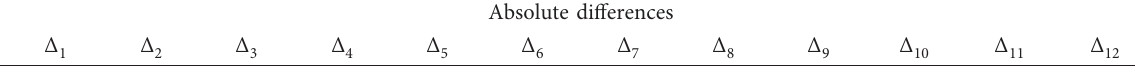
Table 4: Miners’ unsafe behavior variable sequence absolute differences.